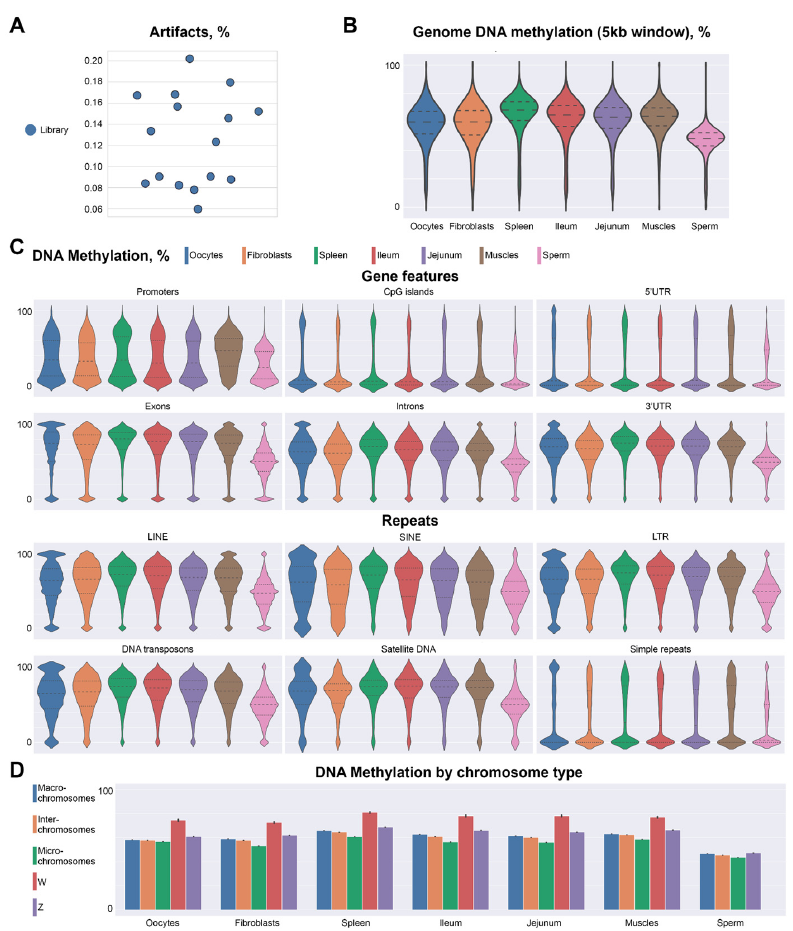
Figure 2. Chicken diplotene oocytes display similarities with somatic cells in DNA methylation pat- terns across chromosome types and genomic features. ( A )—artifacts across all single-cell libraries. ( B )—comparison of genome methylation levels between chicken oocytes and other cell types. ( C )—comparison of methylation levels across genomic features and repeated elements between oocytes and different cell types. ( D )—DNA methylation for different chromosome types.